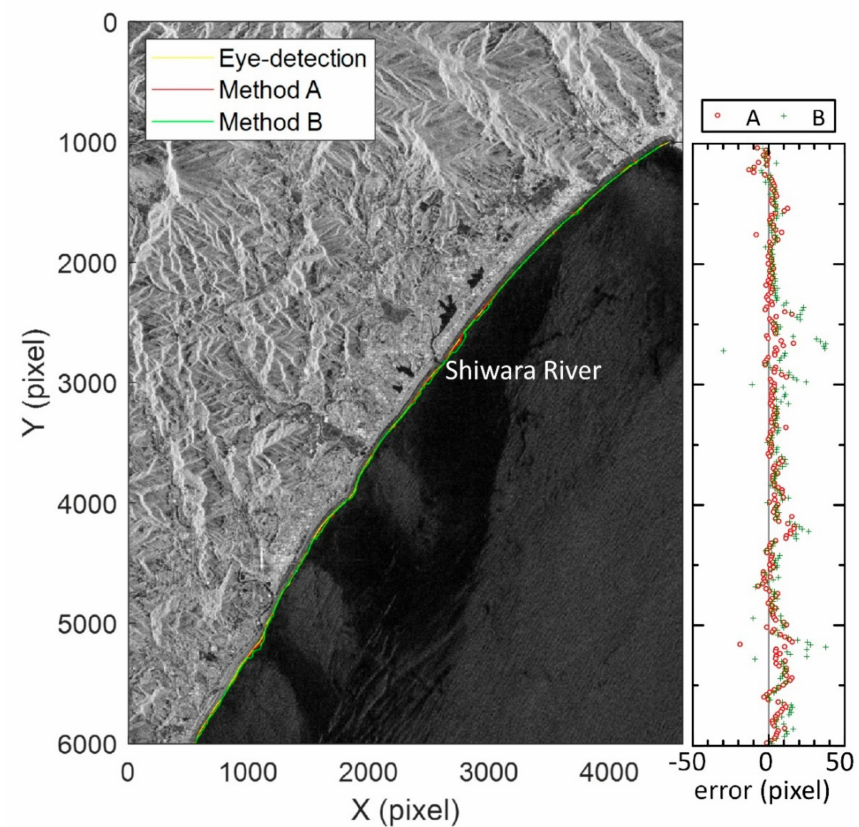
Figure 14. Grayscale image of the Shirimi-hama coast with extracted shorelines ( left ) and the differ- ences in the shoreline position between the eye-detected one and those from the NN models ( right